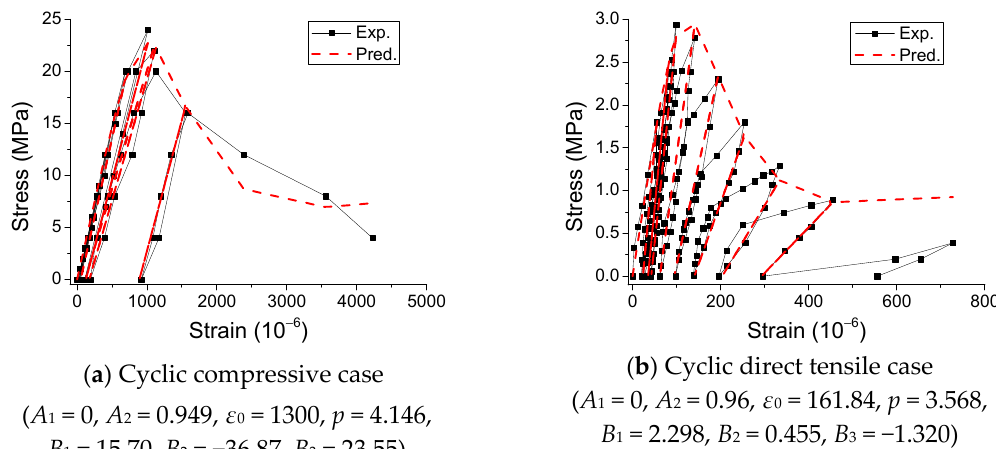
Figure 18. Stress-strain curves of SCC under monotonic loading. ( a ) Cube specimens under compression, ( b ) Prismatic specimens under compression, ( c ) Prismatic specimens under direct tension and ( d ) Mean σ - ε curve under direct tension.